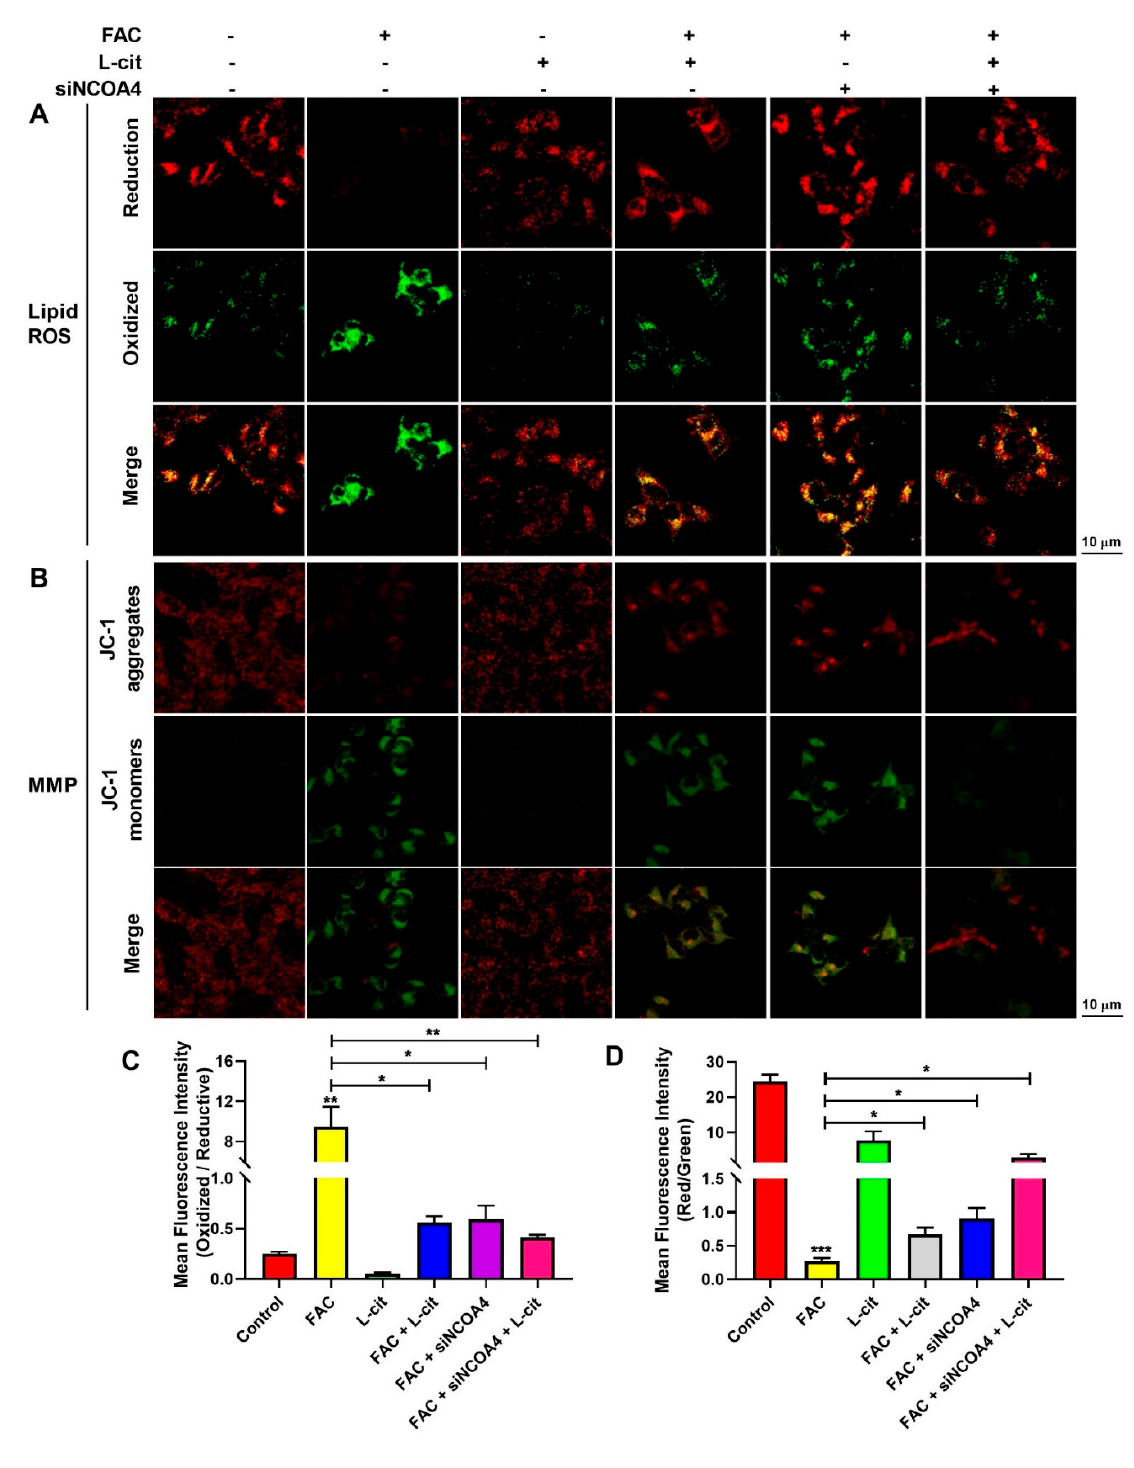
Figure 7. L-cit suppresses ferritinophagy to ameliorate FAC-induced lipid ROS accumulation and MMP elevation in mTEC1 cells. The mTEC1 cells were transfected with 50 nM siNCOA4, followed by 2 mM L-cit, and treated with 200 µ M FAC for 24 h. ( A , B ) Lipid ROS detection using C11 BODIPYTM 581/591 fluorescent probe. Green fluorescence indicates oxidized and red fluorescence indicates reduction. ( C , D ) Mitochondrial membrane potential (MMP) detection by JC-1 fluorescent probe. Green fluorescence indicates JC-1 monomer and red fluorescence indicates JC-1 aggregate. Val- ues represent mean ± SEM. of three independent experiments. Significant differences are represented by * p < 0.05, ** p < 0.01, *** p <